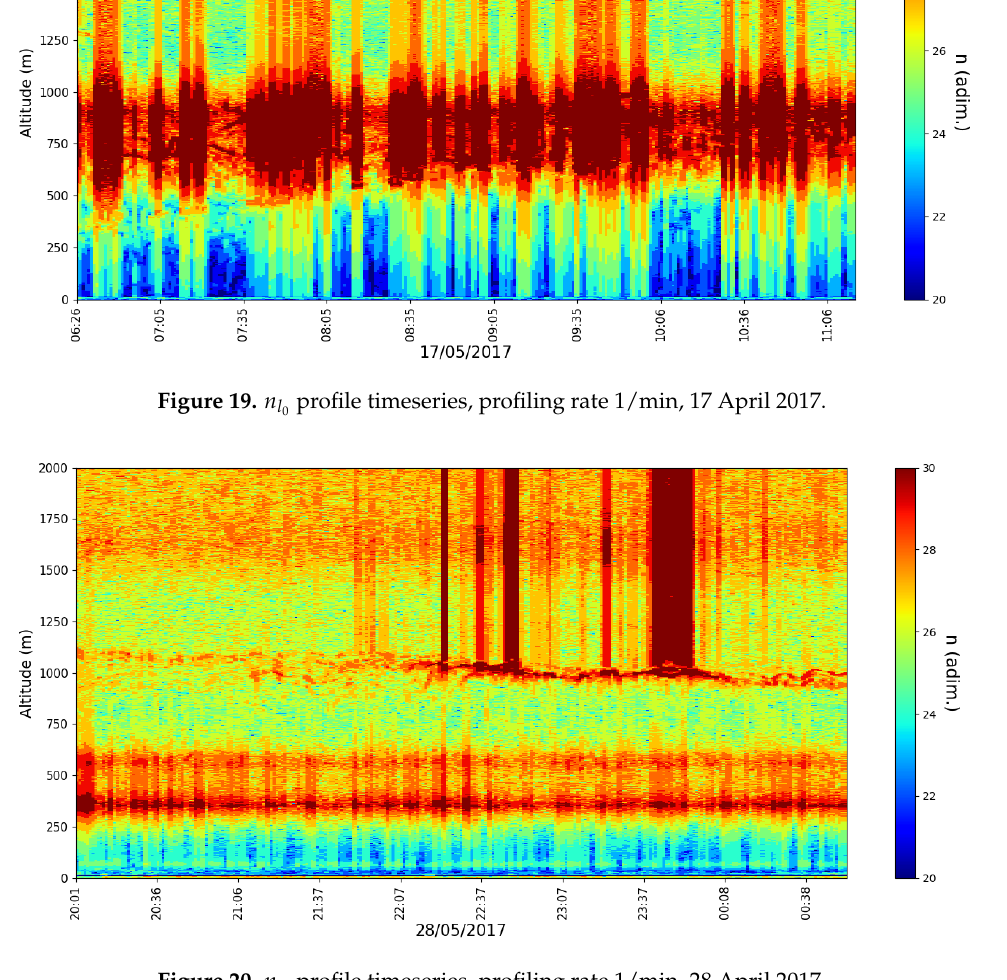
Figure 20. 𝑛 𝑙 profile timeseries, profiling rate 1/min, 28 April 2017. Figure 20. n 0 l 0 profile timeseries, profiling rate 1/min, 28 April